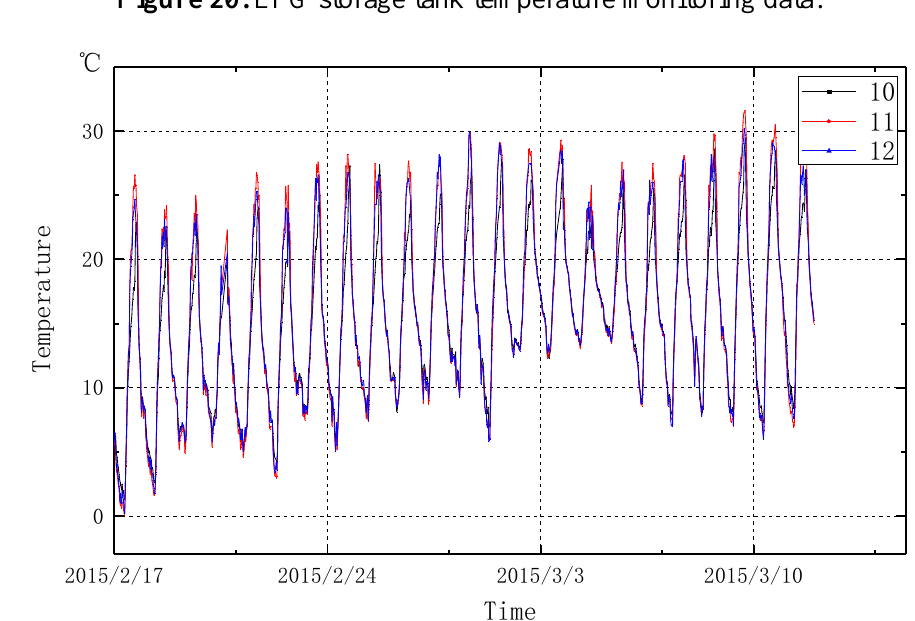
Figure 20. LPG storage tank temperature monitoring data.